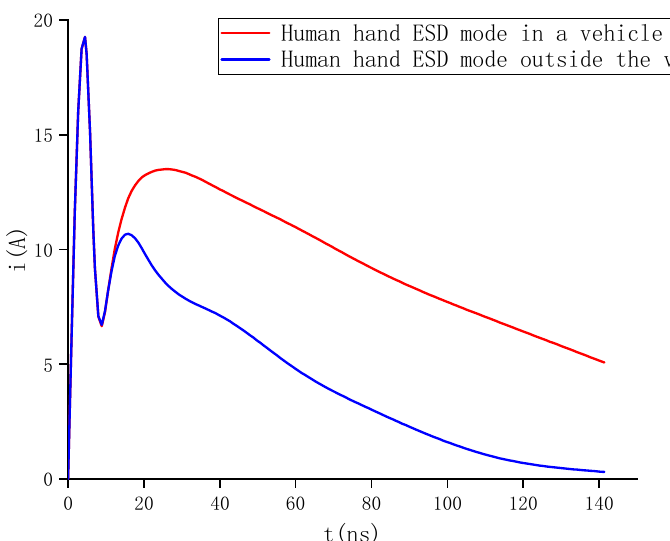
Figure 5. Human hand ESD mode in a vehicle and human hand ESD mode outside the vehicle.